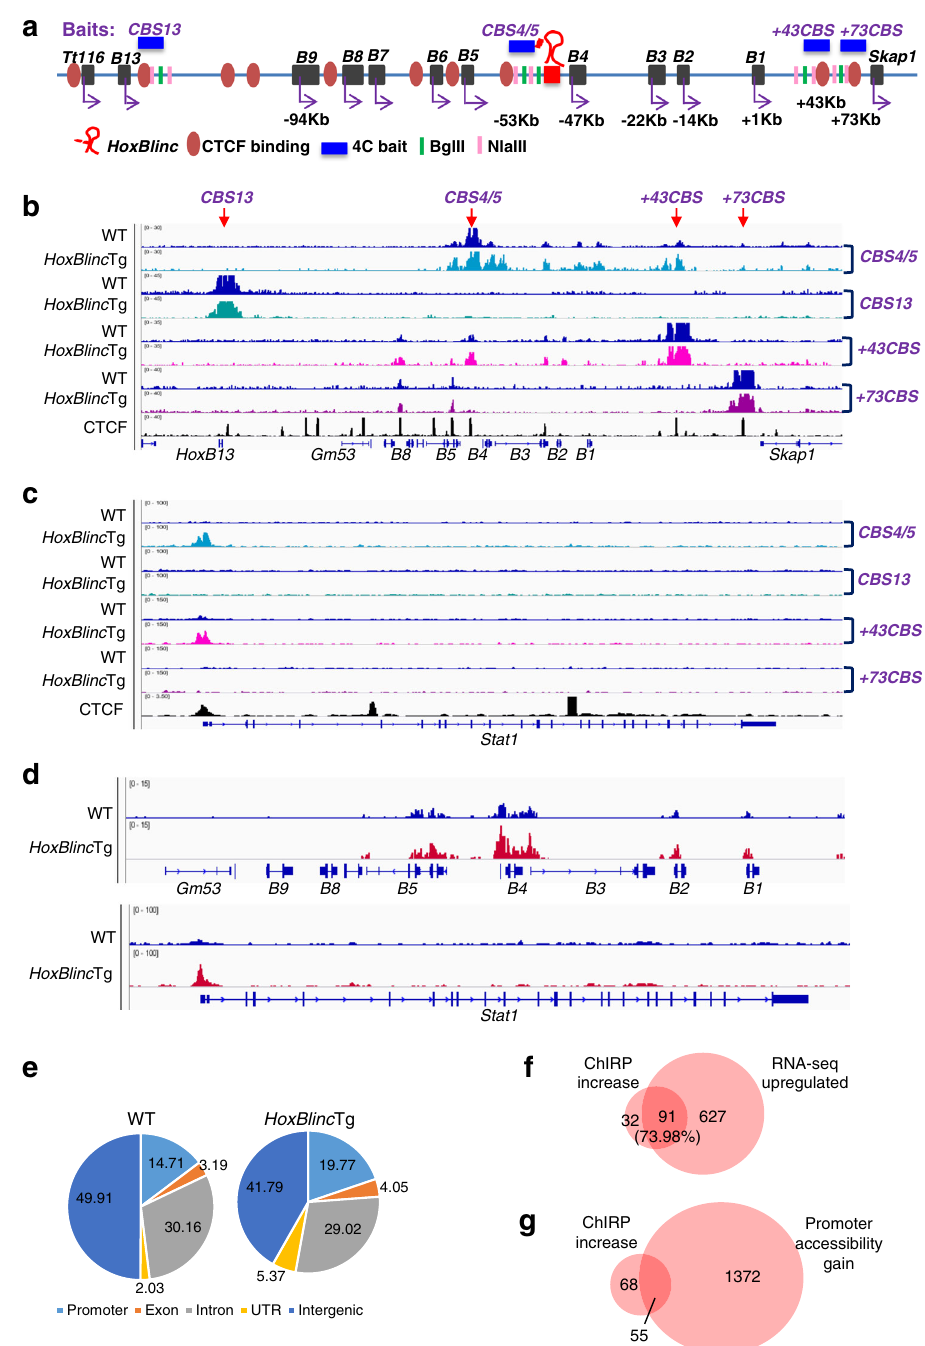
Fig. 5 HoxBlinc directly binds to target genes and mediates chromatin interactions to drive gene regulatory networks in HSPCs. a Schematic diagram showing the CTCF binding sites (CBS), location of the 4C baits in HoxB locus of the mouse genome. b , c Long-range chromatin interactions with HoxB locus (4 baits) as determined by 4C-seq analysis in WT and HoxBlinc Tg Lin − c-Kit + cells. HoxBlinc overexpression increased the interactions of CBS4/5 and + 43CBS with the HoxB genes ( b ), HoxBlinc overexpression also enhanced the interaction of CBS4/5 or + 43CBS with Stat1 promoter region ( c ), ChIP-seq analysis of CTCF binding sites was obtained from the NCBI GEO public database (GSM918748). d ChIRP-seq analysis of HoxBlinc bindings to the HoxB and Stat1 gene loci in WT and HoxBlinc Tg Lin − c-Kit + cells. e The pie chart shows the distribution of promoter, exon, intron, UTR, and intergenic region within the total HoxBlinc binding sites in WT ( left ) and HoxBlinc Tg ( right ) Lin − c-Kit + cells as identi fi ed by ChIRP-seq. f Overlap of genes with HoxBlinc binding gain to their promoter regions as identi fi ed by ChIRP-seq and the upregulated genes as identi fi ed by RNA-seq in HoxBlinc Tg vs. WT HSPCs. g Overlap of genes with HoxBlinc binding gain to their promoter regions as identi fi ed by ChIRP-seq and genes with promoter accessibility gain as identi fi ed by ATAC-seq in HoxBlinc Tg vs. WT